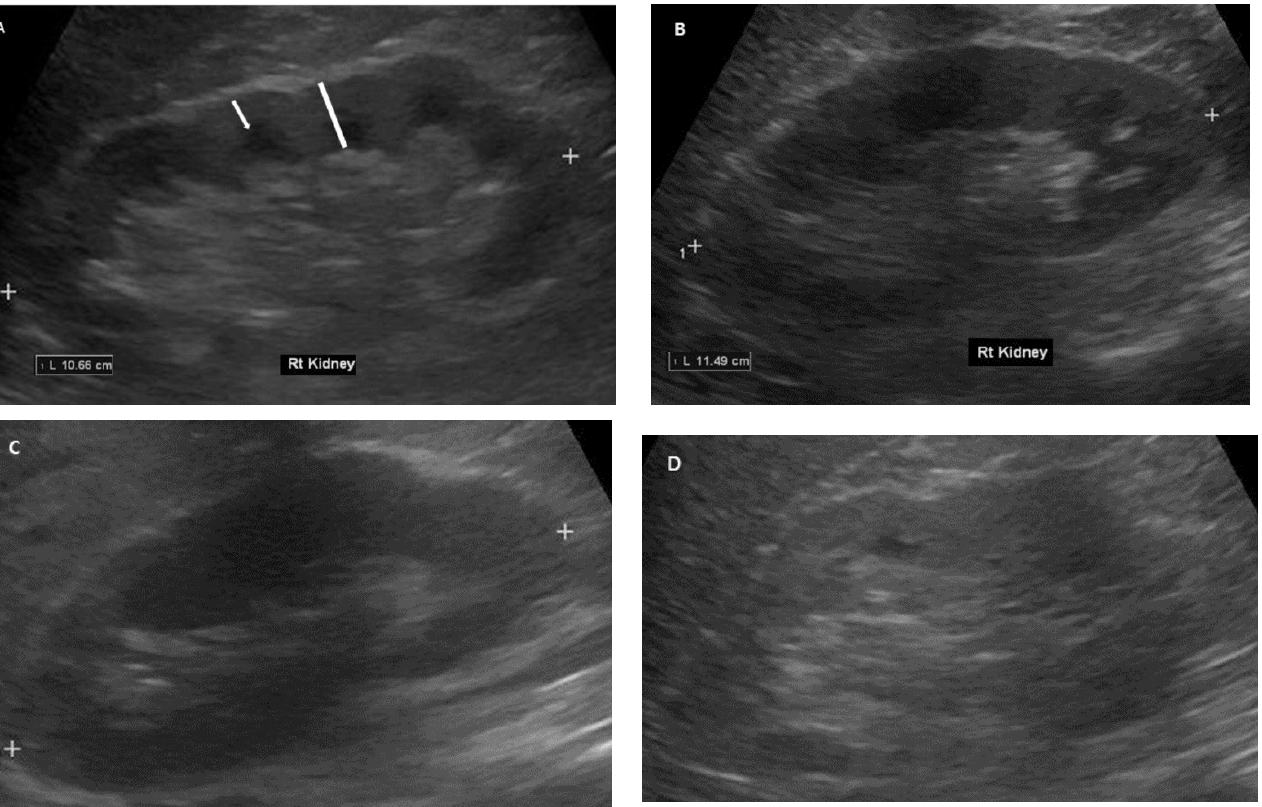
Figure 1. Representative pictures of ultrasound findings: ( A ) a 63-year-old male with normal renal ultrasound; ( B ) a 54-year-old female with diabetes; ( C ) a 54-year-old male with eGFR > 60 mL/min/1.73 m 2 ; ( D ) a 65-year-old male with eGFR 45 mL/min/1.73 m 2 (arrow: measurement of cortical thickness; bar: measurement of parenchymal thickness).